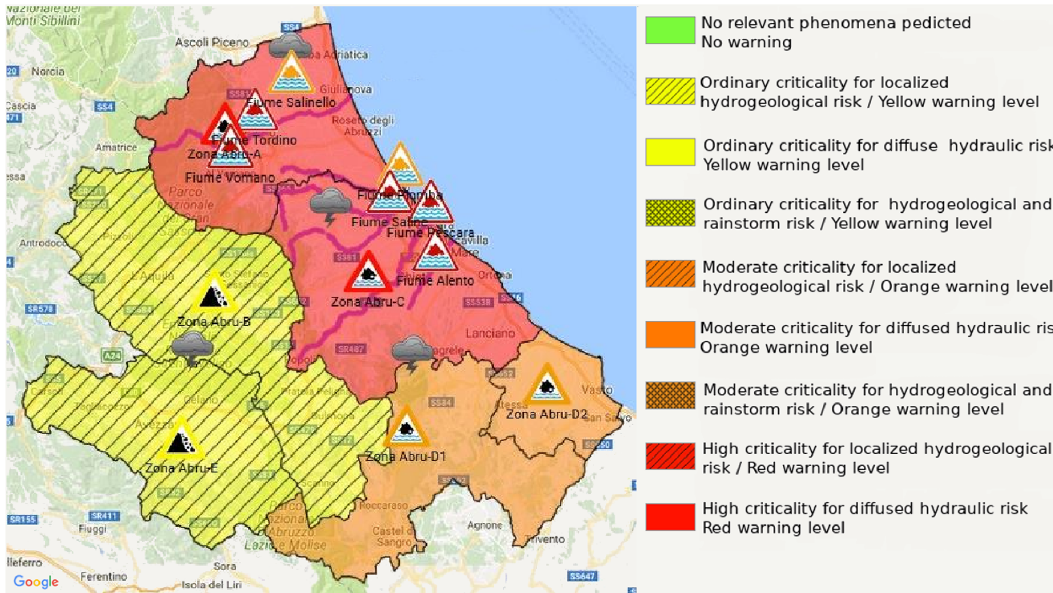
Figure 9. Hydrogeological-criticality bulletin issued by the Civil Protection Department on the morning of 15 November 2017, where the Abruzzo region territory is divided into six warning areas (indicated by the prefix “Zona Abru”), coloured according to the included legend. Triangle-shaped, thin-bounded signs are geolocated over relevant hydrometers and coloured according to the colour code explained in Fig. 7, resulting from observed data. Triangle-shaped, thick-bounded signs indicate the forecasted warning level in the reference warning area. Yellow triangles indicate landslide risk at the warning area level, while thunderstorm risk is assigned through a figurative icon. Purple lines on the coastal warning areas highlight river segments where the red threshold has been overpassed. © Google Maps